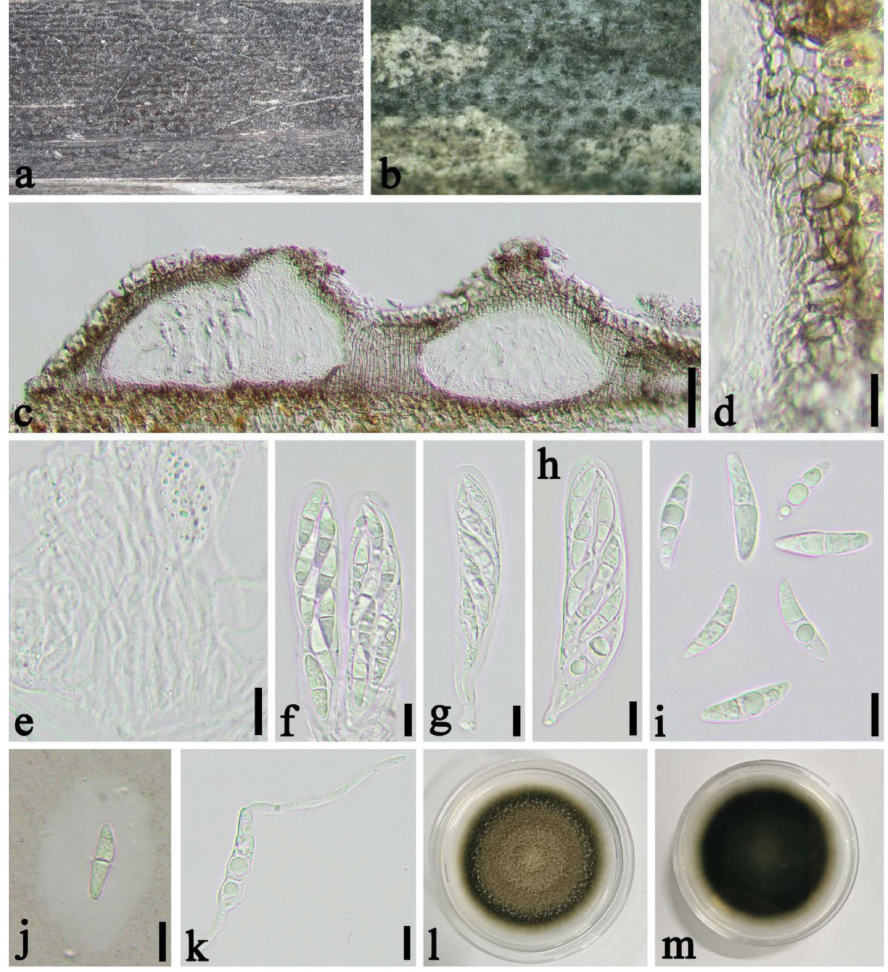
Figure 12. Seriascoma yunnanense (SICAU 22-0059). ( a , b ) Ascostromata developing on the host. ( c ) Vertical sections of ascostromata. ( d ) Peridium. ( e ) Pseudoparaphyses. ( f – h ) Asci. ( i , j ) Ascospores. ( k ) Germinating ascospore. ( l , m ) Cultures on PDA. Scale bars: ( c ) = 50 µ m, ( d – k ) = 10 µ m. Material examined: China, Sichuan Province, Chengdu City, Jin’niu District (30 ◦ 45 (cid:48) 57 (cid:48)(cid:48) N, 104 ◦ 7 (cid:48) 34 (cid:48)(cid:48) E, Alt. 539 m), on dead culm of Phyllostachys edulis , 8 April 2021, Yicong Lv, LYC202104043 (SICAU 22-0059), living culture SICAUCC